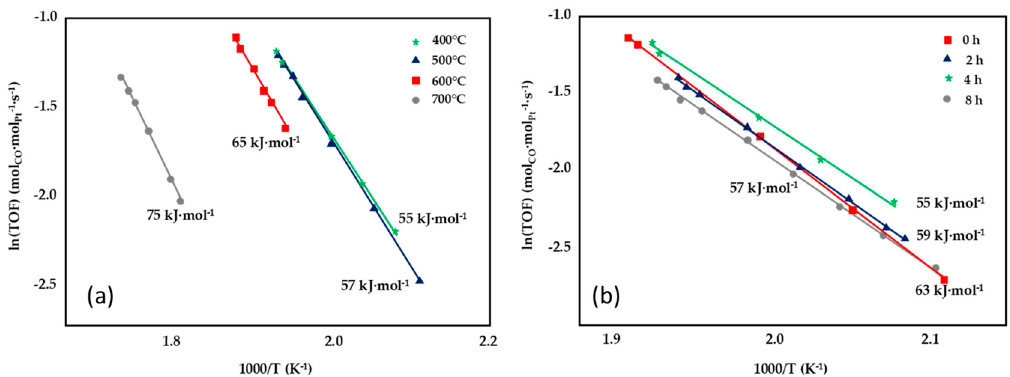
Figure 11. Effect of pre-calcination temperature ( a ) and aging time ( b ) on the Arrhenius plots of the turnover frequency, adapted from [81], with permission from Elsevier, 2015; CO conversion obtained over Pt/CeO 2 catalysts tested at P = 1 atm, 6.5% CO, 7.1% CO 2 , 0.7% CH 4 , 42.4% H 2 , 28.7% H 2 O, 14.5% N 2 , GHSV = 45,515 h − 1 .